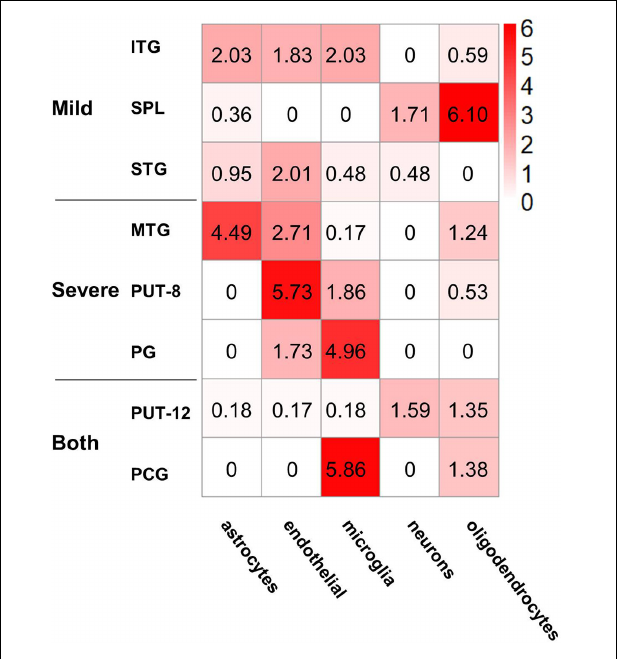
regions. The heatmap shows the enrichment results of five kinds of cell type-specific genes in the eight non-preserved modules, the color in heatmap illustrated the negative logarithm of P-value of the enrichment, from white (-log( P -value) = 0) to red (-log( P -value) > 6). The significant cutoff is defined as 1.3, which is equivalent to P -value